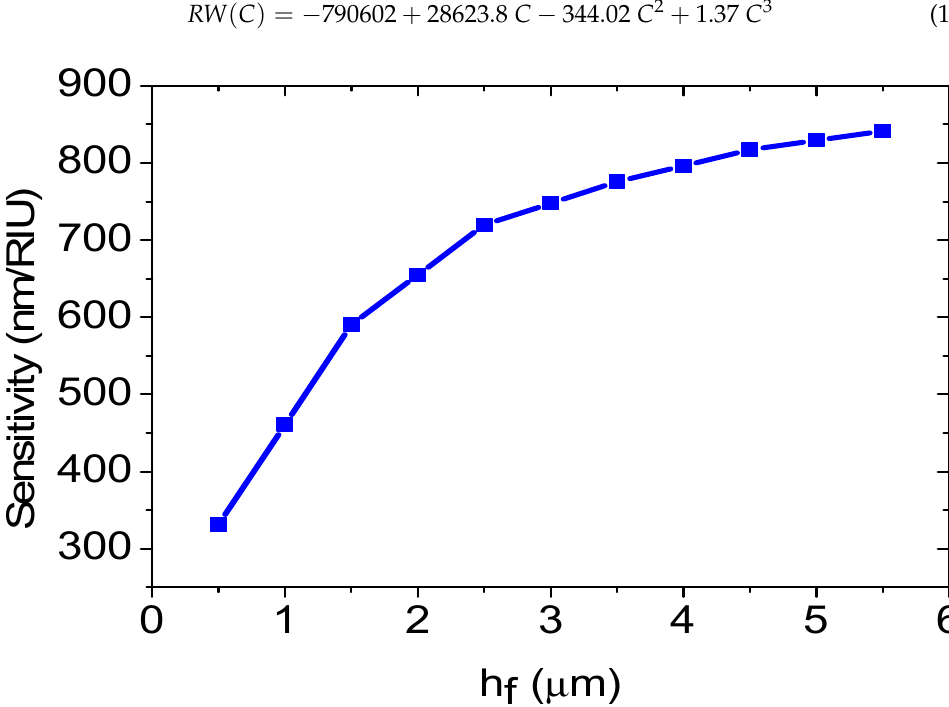
Figure 7. Transmittance curves of the suggested TPC biosensor with different thicknesses of cavity